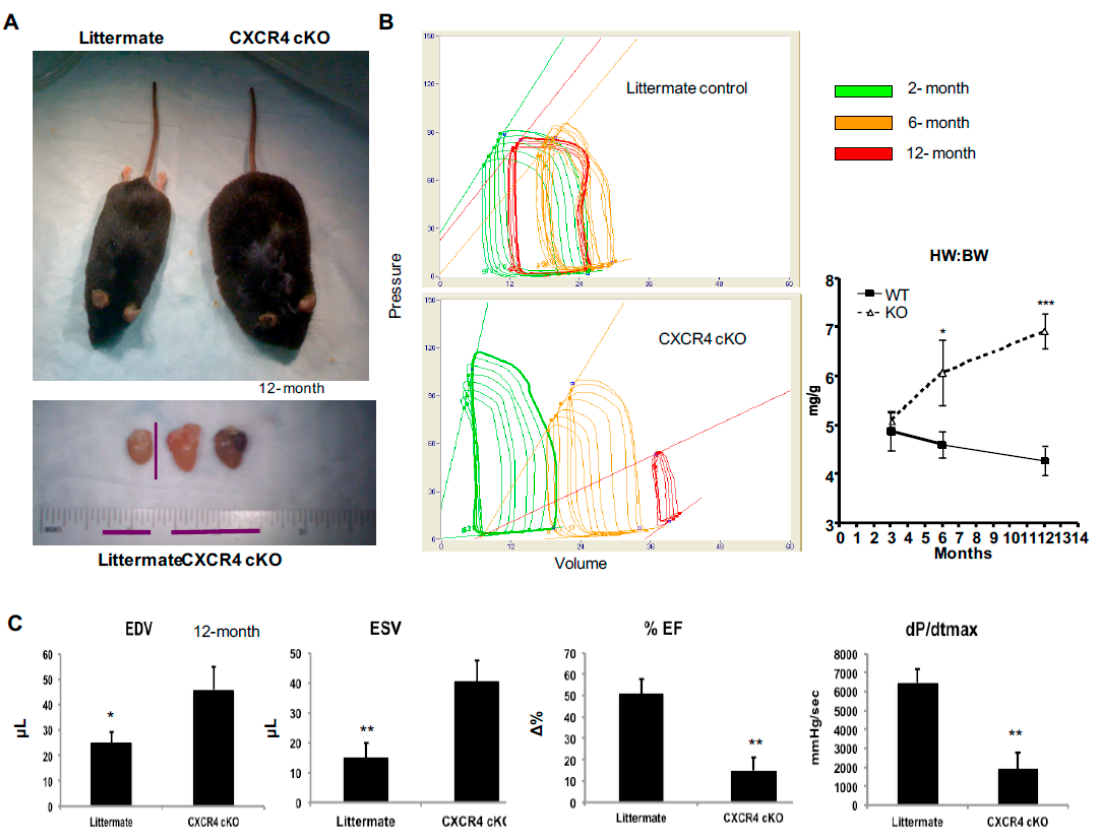
Figure 1. CXCR4 cardiac specific knockout (cKO) phenotype. We have successfully crossed the CXCR4 flox / flox (CXCR4 fl / fl4 ) mice that possess both CXCR4 alleles with flox sites flanking CXCR4 exon 2 with the α -MHC Cre (Cre +/ 0 ) mice. ( A ) During our observational period, we noticed that study mice were very sick by the age of 12 months and that most died by 12–14 months. Phenotypic analyses of CXCR4 cKO at 12 months of age revealed significant peritoneal fluid collection, which correlated with an increase in the heart weight to body weight ratio. ( B ) In vivo hemodynamic data were acquired using a pressure-volume conductance catheter via an open-chest approach on mice aged 2- (green), 6- (orange), and 12-months (red) of ages are shown at baseline. Pre-load reduction studies were carried out by transiently occluding the inferior vena cava. Heart weight body weight ratio was assessed at 2-, 6-, and 12-months of age. ( C ) In vivo hemodynamic data were acquired and analyzed using 10 × 2 software, as demonstrated here. One-way ANOVA with Tukey’s post-hoc test was performed between all groups at each time point (n = 5–7 mice/group).